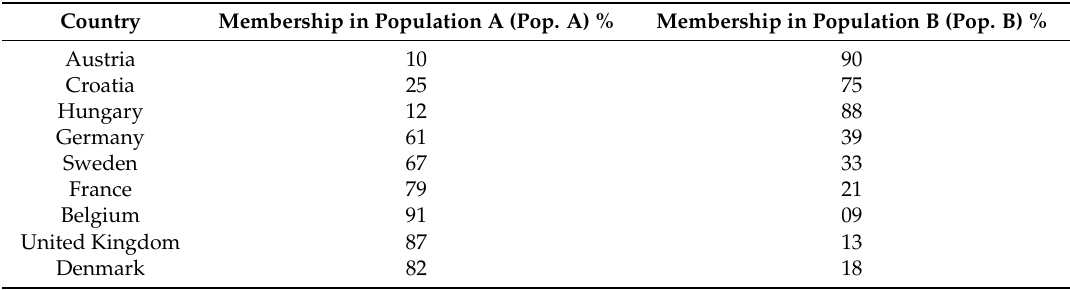
Table 5. Membership proportion of wheat varieties of each of the nine European counties in each of the two populations ( K = 2) generated by Structure analysis